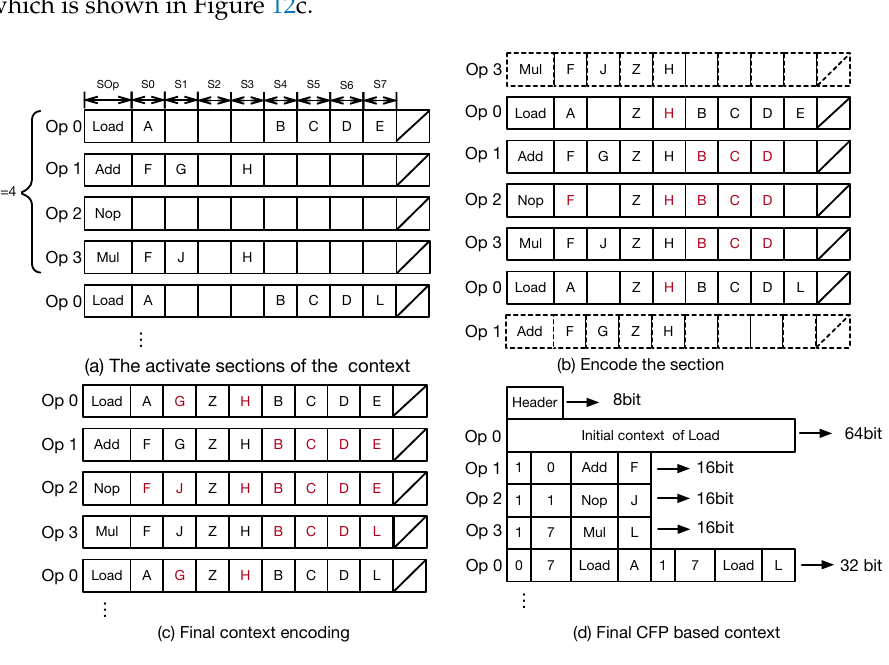
Figure 12. Inactive bit encoding and CFP-based context-generation